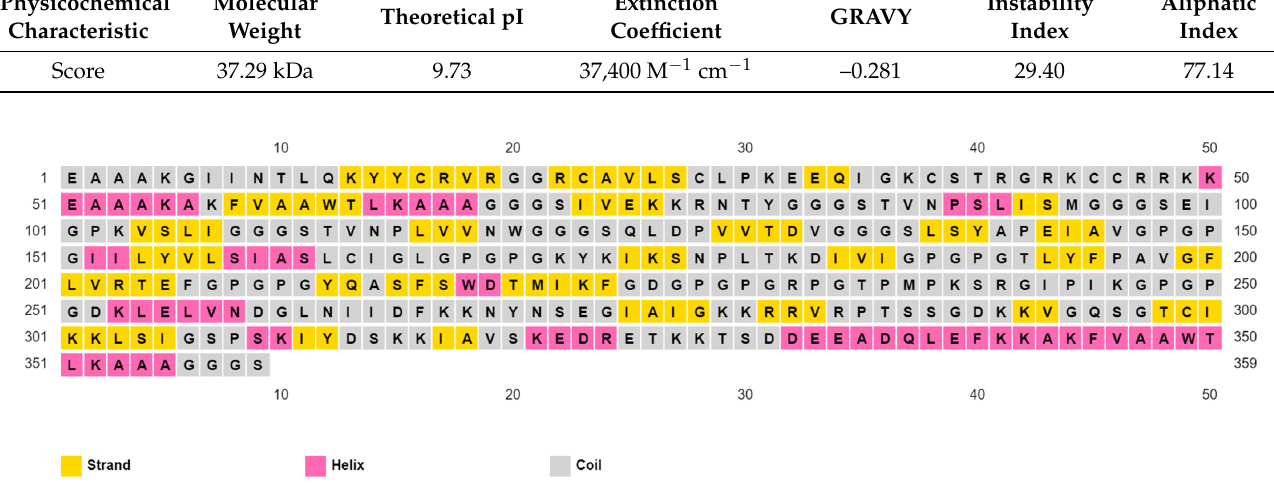
Figure 4. Secondary structure prediction of designed multitope vaccine using PESIPRED server.